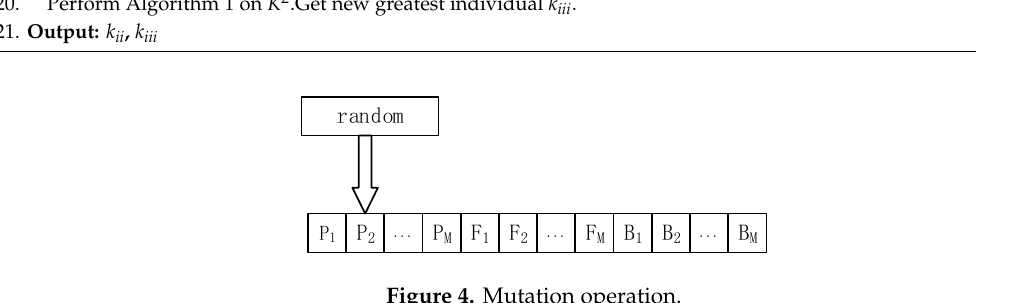
Algorithm 2 Crossover and mutation